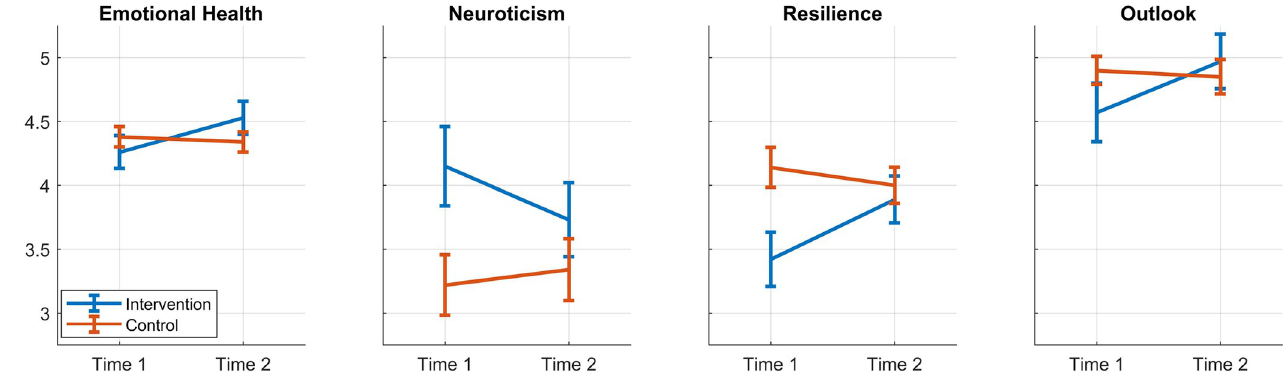
Fig 2. Phase 1 significant effects. Graphical representations of significant effects observed between pre- and post-test means in four measures for intervention and control groups. The vertical bars represent standard error of the mean.